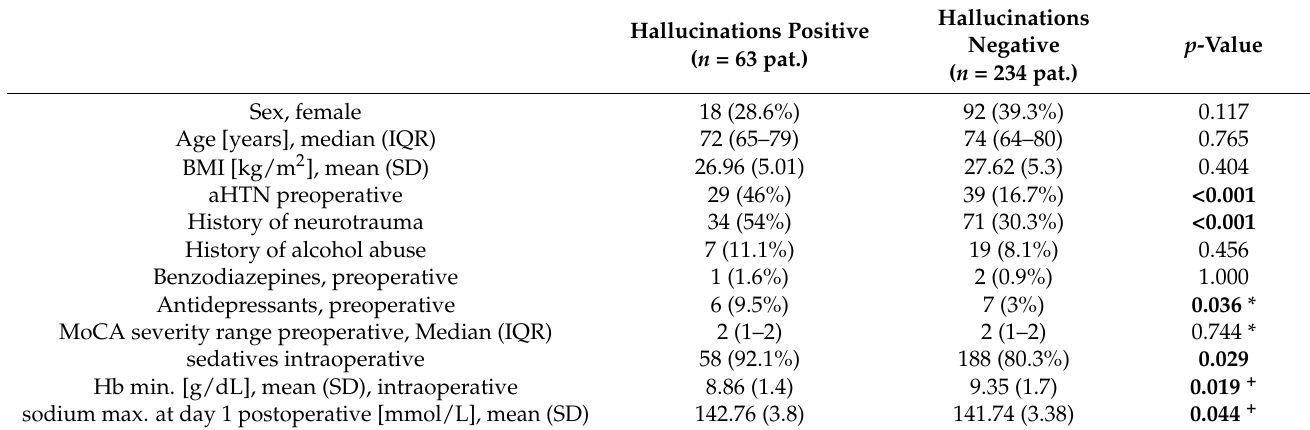
Table A3. Clinical characteristics and risk factors in patients with and without